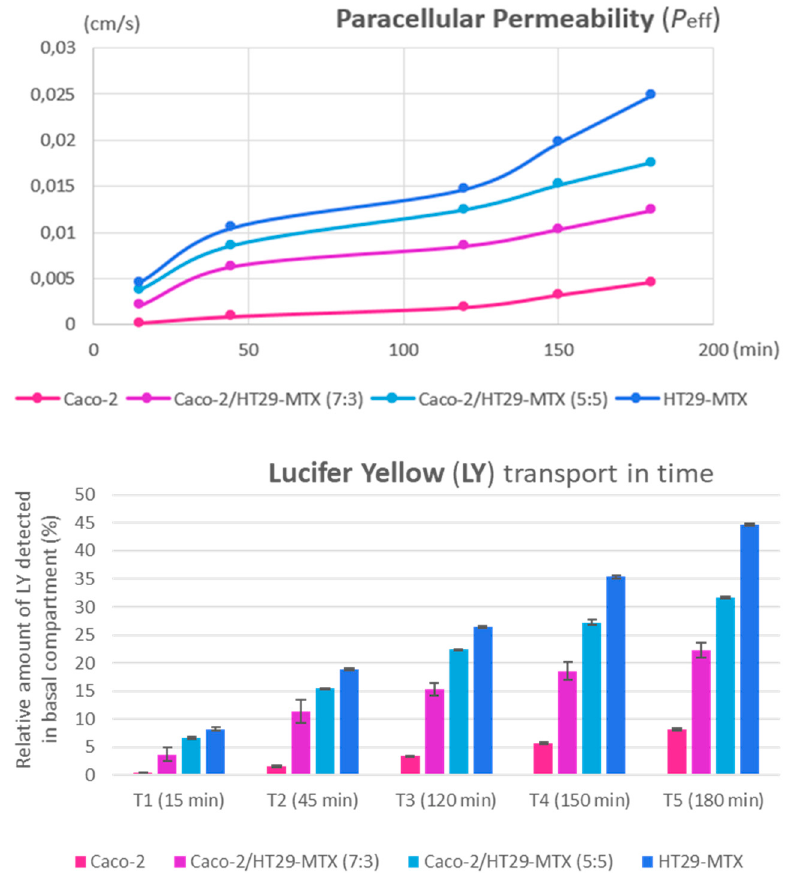
Figure 8. Effective permeability increases across all intestinal in vitro variants (top graph). Lucifer Yellow transport over time (bottom graph) shows the relative amount (in percentages) of the paracellular marker, which was detected at five measurement points during the experiment. Data are calculated as means ± standard deviation (SD) (n = 3).